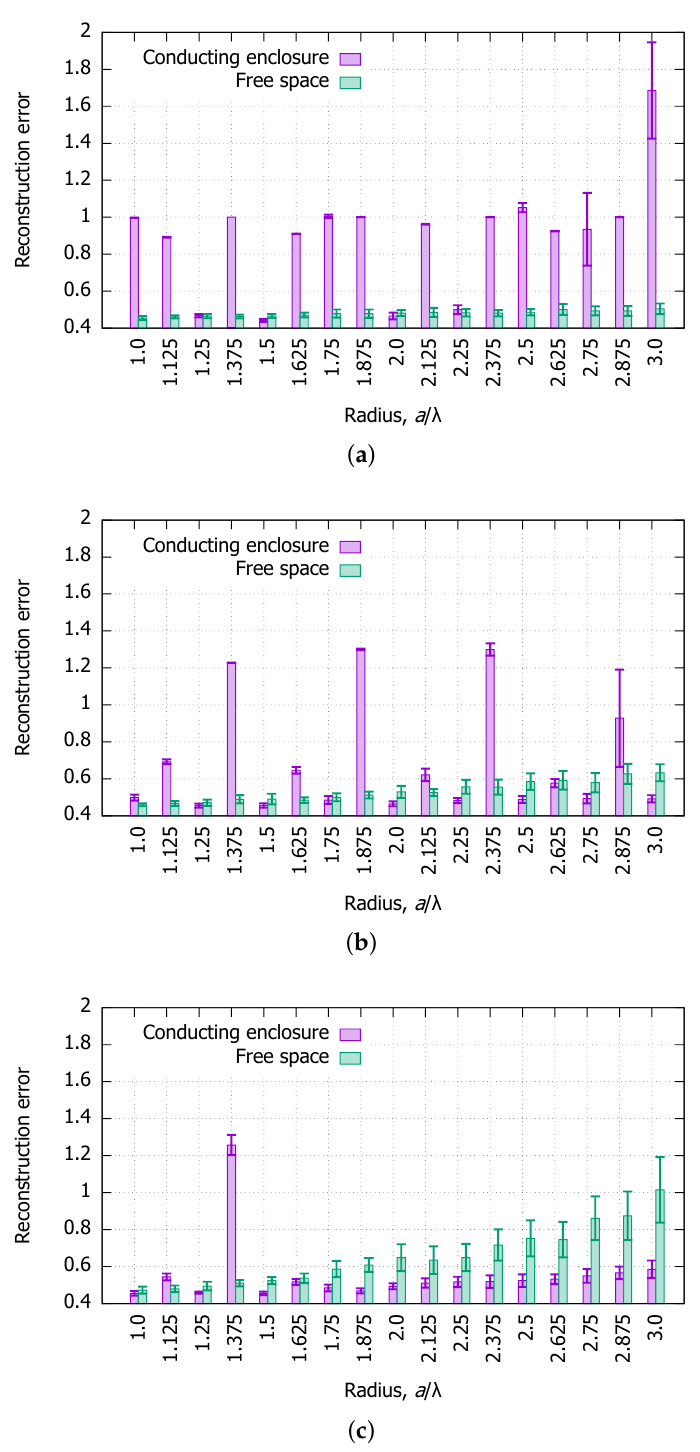
Figure 8. Large conducting enclosure. Reconstruction error versus the radius of the conducting enclosure: ( a ) σ b = 0 S/m; ( b ) σ b = 1 mS/m; ( c ) σ b = 2